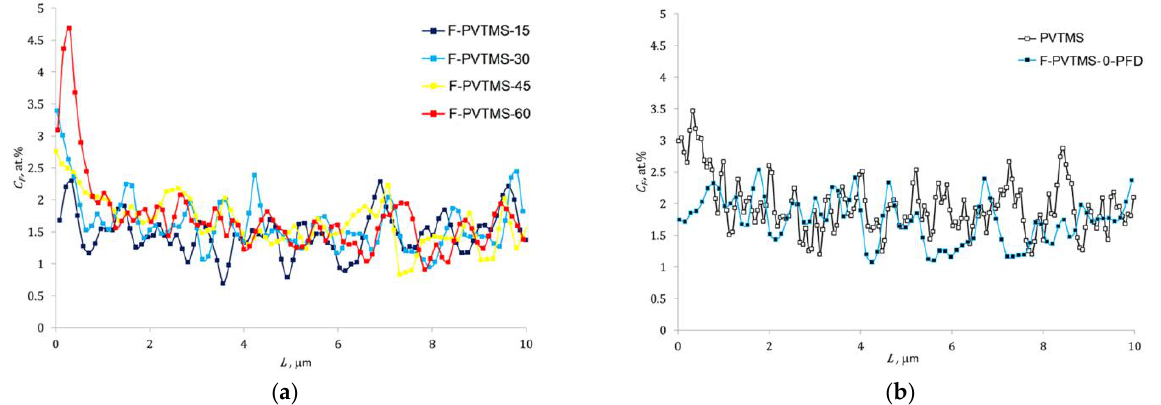
Figure 9. Fluorine content distribution over the thickness of the PVTMS film: ( a )—depending on the fluorination time; ( b )—for the virgin PVTMS sample and for the sample soaked in perfluorodecalin for 30 min (F-PVTMS-0-PFD).